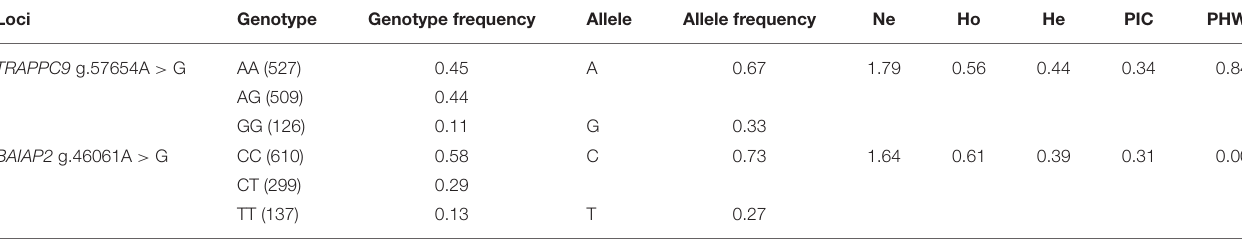
TABLE 5 | The genotype frequency, allele frequency, and genetic diversity of the TRAPPC9 and BAIAP2 SNP sites.